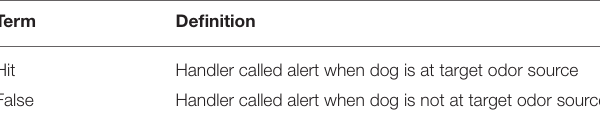
TABLE 2 | Data recorded during both single-blind and double-blind